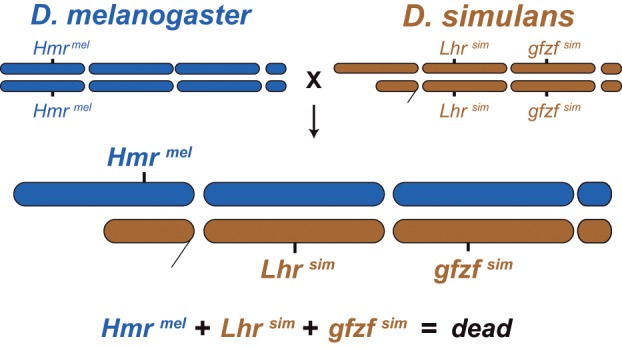
Three genes are required for F1 male lethality. Hmrmel, Lhrsim, and gfzfsim are all required for hybrid F1 male lethality between Drosophila melanogaster and Drosophila simulans.